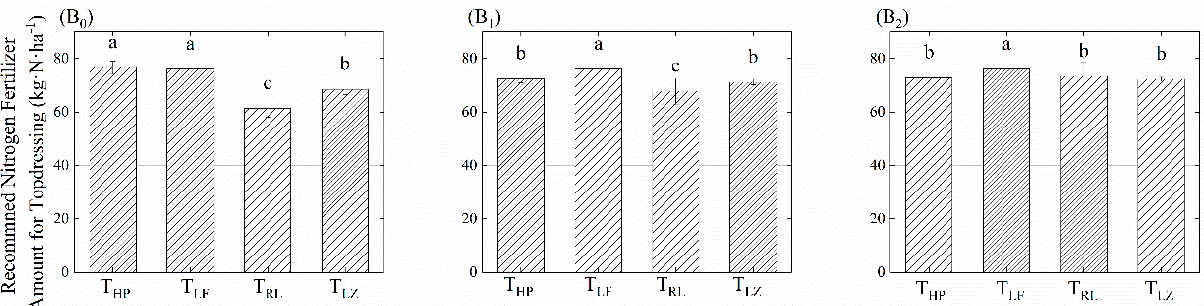
Figure 7. Recommended nitrogen fertilizer amount for topdressing under different basal fertilizer levels. (B 0 , B 1 and B 2 represent basal fertilizer levels of 0, 57 and 114 kg · ha − 1 , respectively; T HP , T LF , T RL , and T LZ represent different topdressing methods; different letters indicate significance using Fischer’s protected least significant difference at p < 0.05).